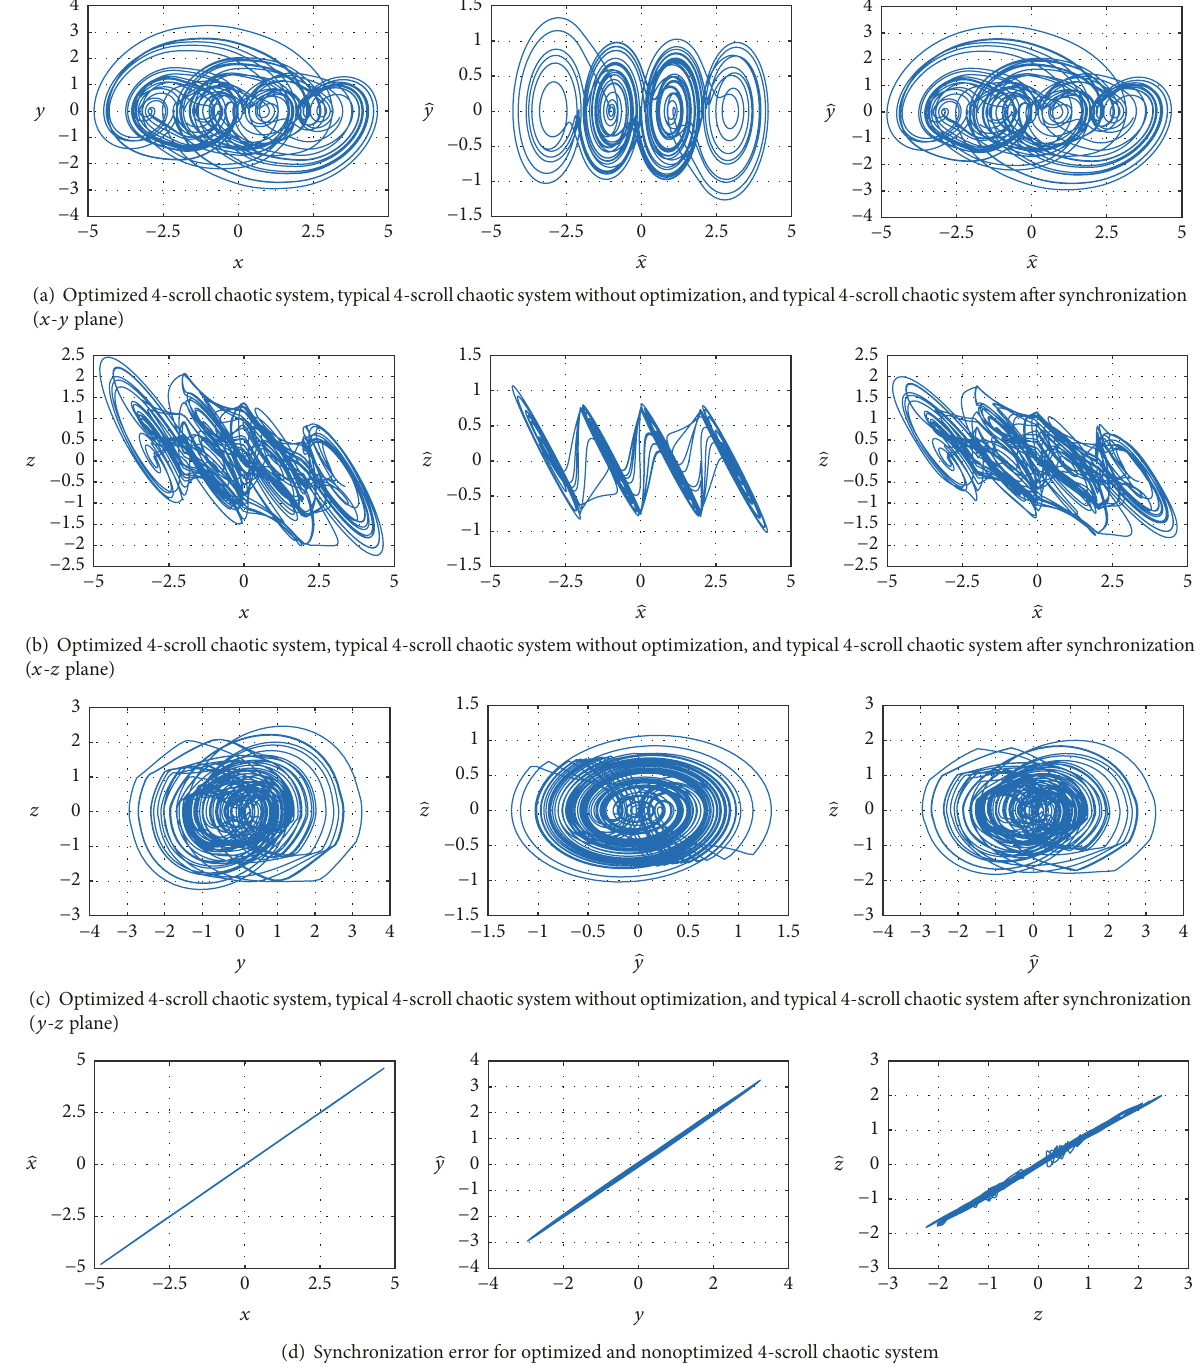
Figure 13: Synchronization results between optimized and nonoptimized chaotic oscillators with different slopes.